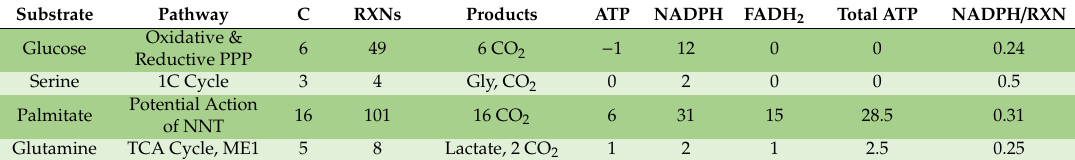
Table 3. ATP and co-factors produced from glucose, palmitate, serine, and glutamine when RedOx balance is the main metabolic constraint. Glucose contributes to the generation of NADPH through the oxidative and reductive cycles of pentose phosphate pathway (PPP). The number of reactions is calculated assuming the smallest number needed to generate the most amount of NADPH. Serine catabolism through mitochondrial one carbon cycle can generate NADPH as a side product of the enzymatic activity of MTHFD2 / L and ALDH1L2. Palmitate oxidation is shown here as an example for the potential of generating reducing power in the form of NADPH via NNT activity. Moreover, all mitochondrial NADH molecules generated in the other examples are assumed to be converted to NADPH. Conversion of malate to pyruvate via ME1 can generate NADPH instead of NADH during glutamine catabolism [145–147]. 1C, one-carbon; NNT, nicotinamide nucleotide transhydrogenase; ME, malic enzyme; RXN, reaction; C, carbons per substrate